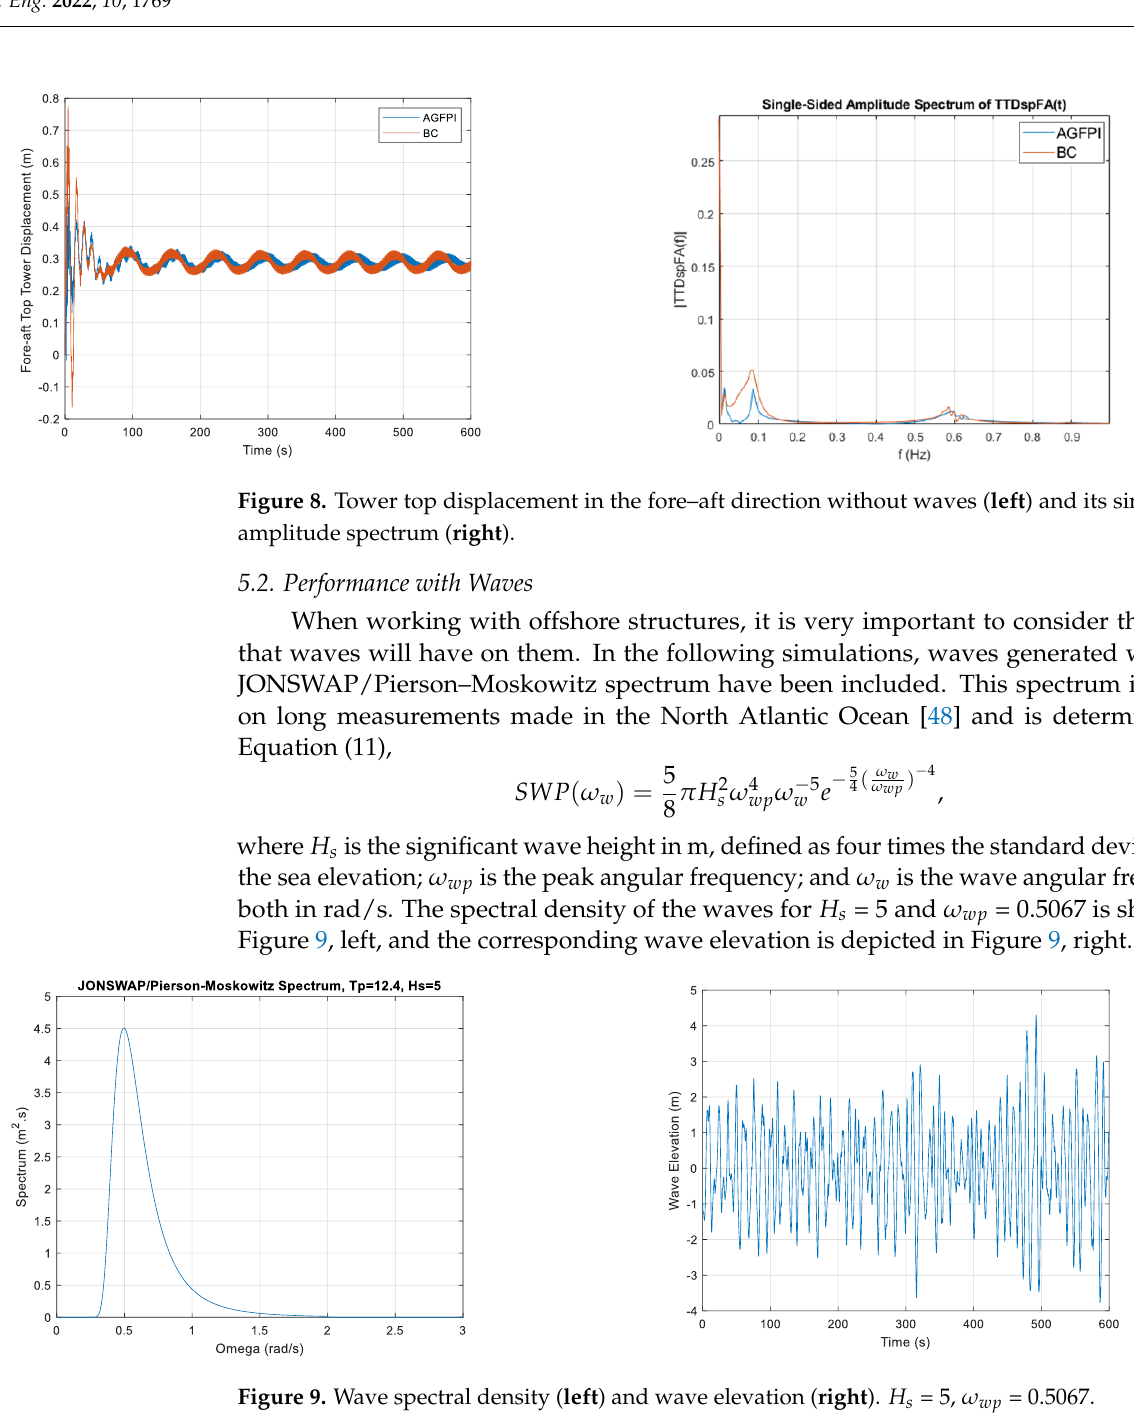
Figure 10. Random 17 m/s mean wind speed. Different test cases have been carried out for different wave heights 𝐻 𝑠 , from 1 to 5 m; it is worth remarking that higher wind speeds are associated with higher wave heights. In all cases, the peak frequency of the wave spectrum is set to 𝜔 𝑤𝑝 = 0.5067 and it is main- tained constant [49]. The software FAST is used to generate irregular waves following the described JONSWAP/Pierson – Moskowitz spectrum. The inclusion of waves in the simu- lation makes the control task more difficult because they are important disturbances for the system. Table 2 lists the test cases. Table 2. Test simulation cases. Test Case Number Average Wind Speed (m/s) Wave Height Hs (m) 1